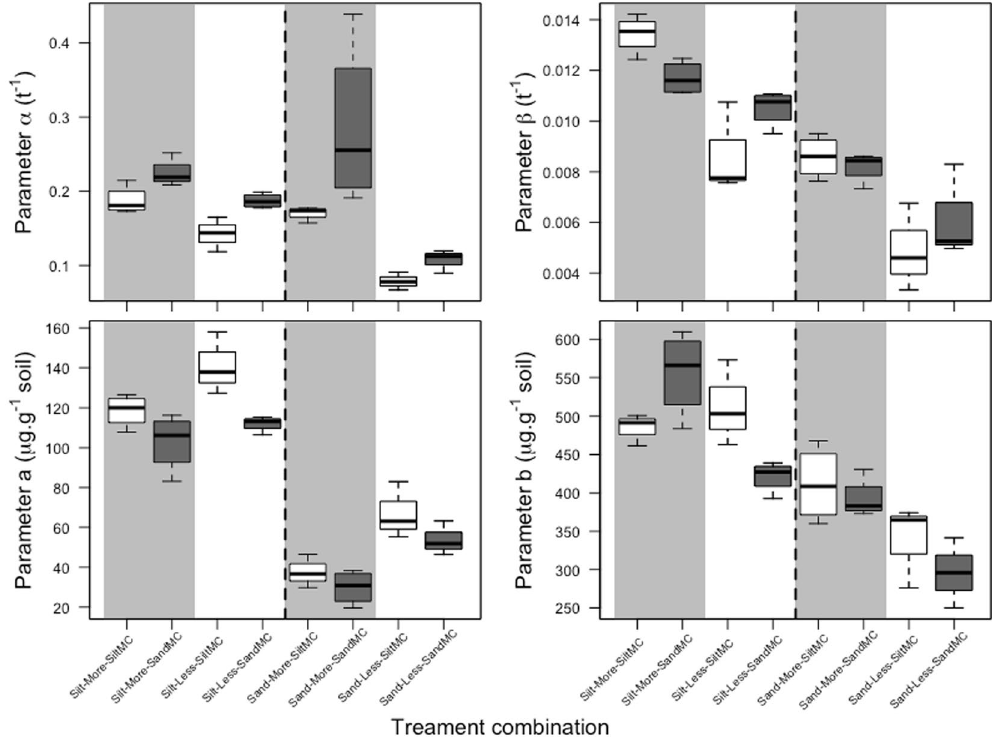
Figure 3. Treatment effects on the rate constant (parameter α ) of the labile pool of organic C (top left panel), on the rate constant (parameter β ) of the slow pool of organic C (top right panel), on the size of the labile pool of organic C (parameter a, bottom left panel) and on the size of the slow pool of organic C (parameter b, bottom right panel). The box-plots on the left of the dashed line are parameters for the silty soil (Silt) and those on the right for the sandy soil (Sand). The box-plots on the white background are the parameters for the less-connected micro-environments (Less) and those on the grey background for the more-connected micro-environments (More). The white box-plots are the parameters for microbial communities from the silty soil (SiltMC) and the dark grey box-plots for the communities from the sandy soil